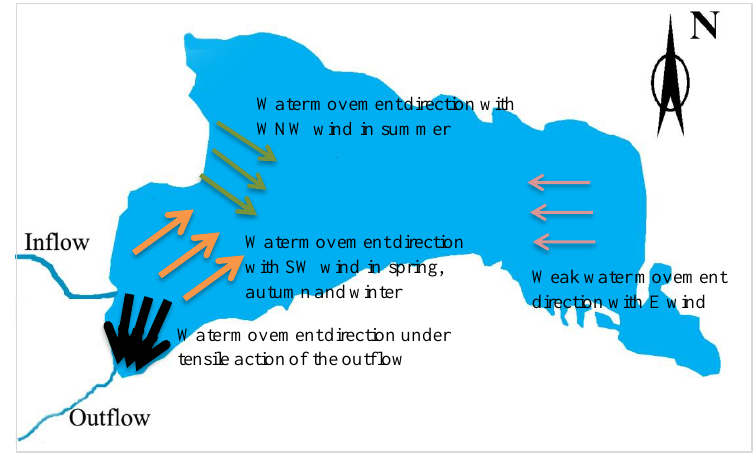
Figure 5. Water movement and water exchange in Bosten Lake.